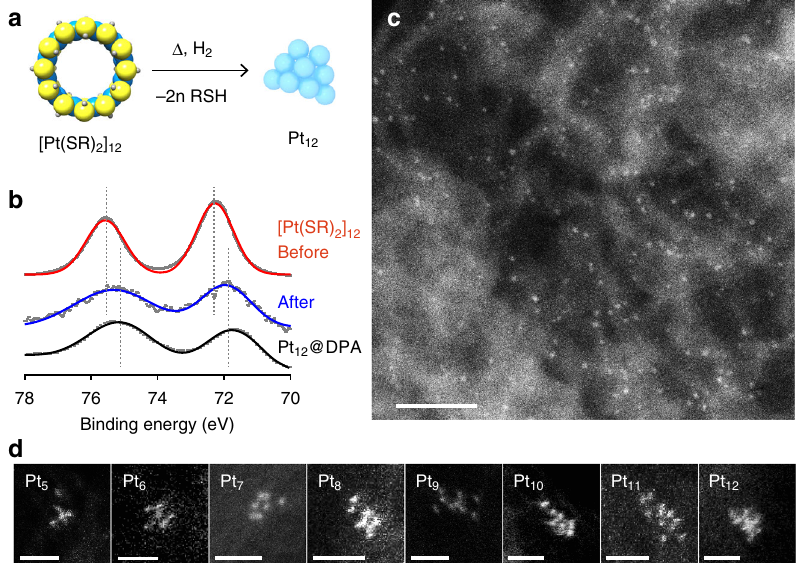
Fig. 2 Preparation of monodispersed Pt 12 clusters from [Pt( µ -SC 8 H 17 ) 2 ] 12 complexes. a Direct conversion scheme from a complex to a cluster by reduction in a hydrogen atmosphere. b XPS of the [Pt( µ -SC 8 H 17 ) 2 ] 12 complexes in Pt 4 f 7/2 and Pt 4 f 5/2 regions before and after calcination at 250°C under